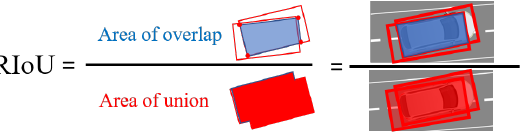
Figure 6. Calculation of